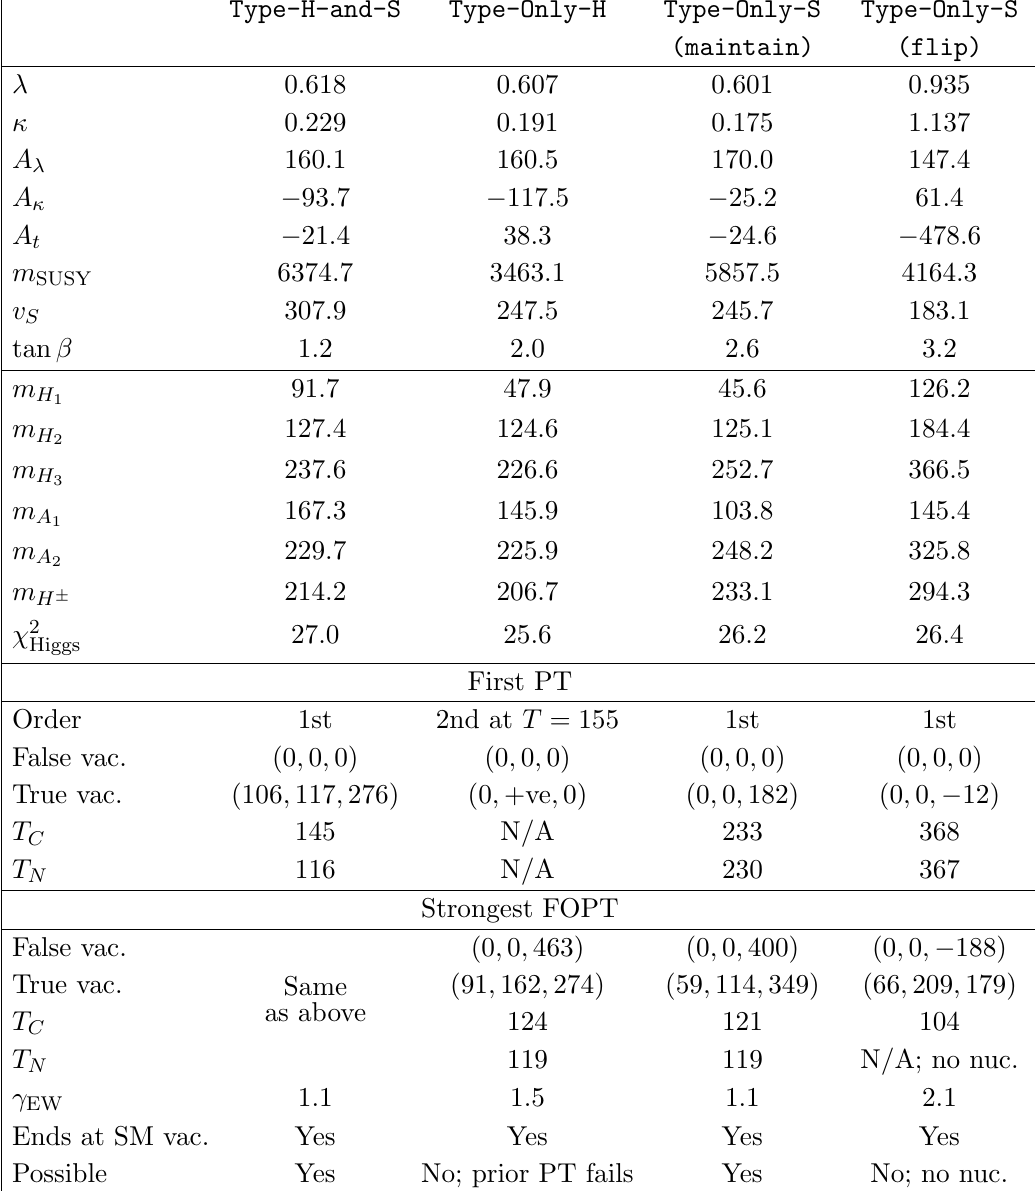
Table 2 . Benchmark points for our four scenarios. All dimensionful quantities are in GeV. The abbreviation vac. is for vacuum and nuc. is for nucleation. The +ve in Type-Only-H means that the (cid:12)eld value of vacuum during the 2nd order phase transition is shifted to positive